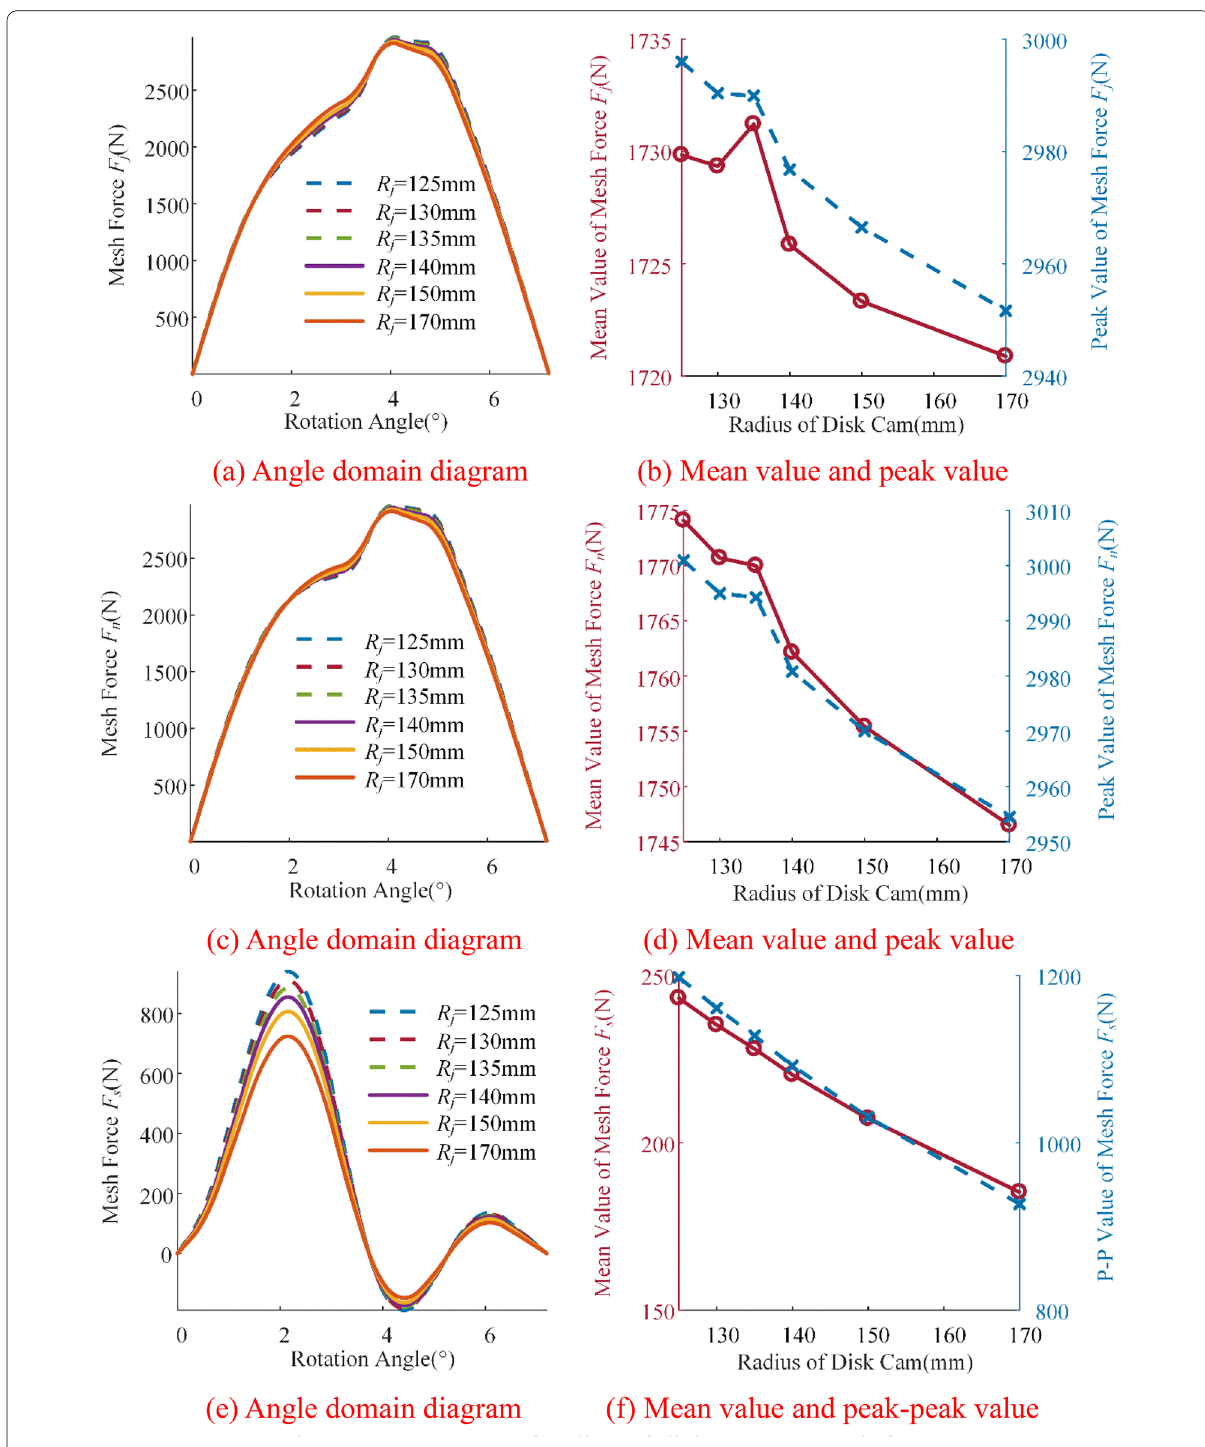
Figure 13 Impacts of radius of disk cam on mesh